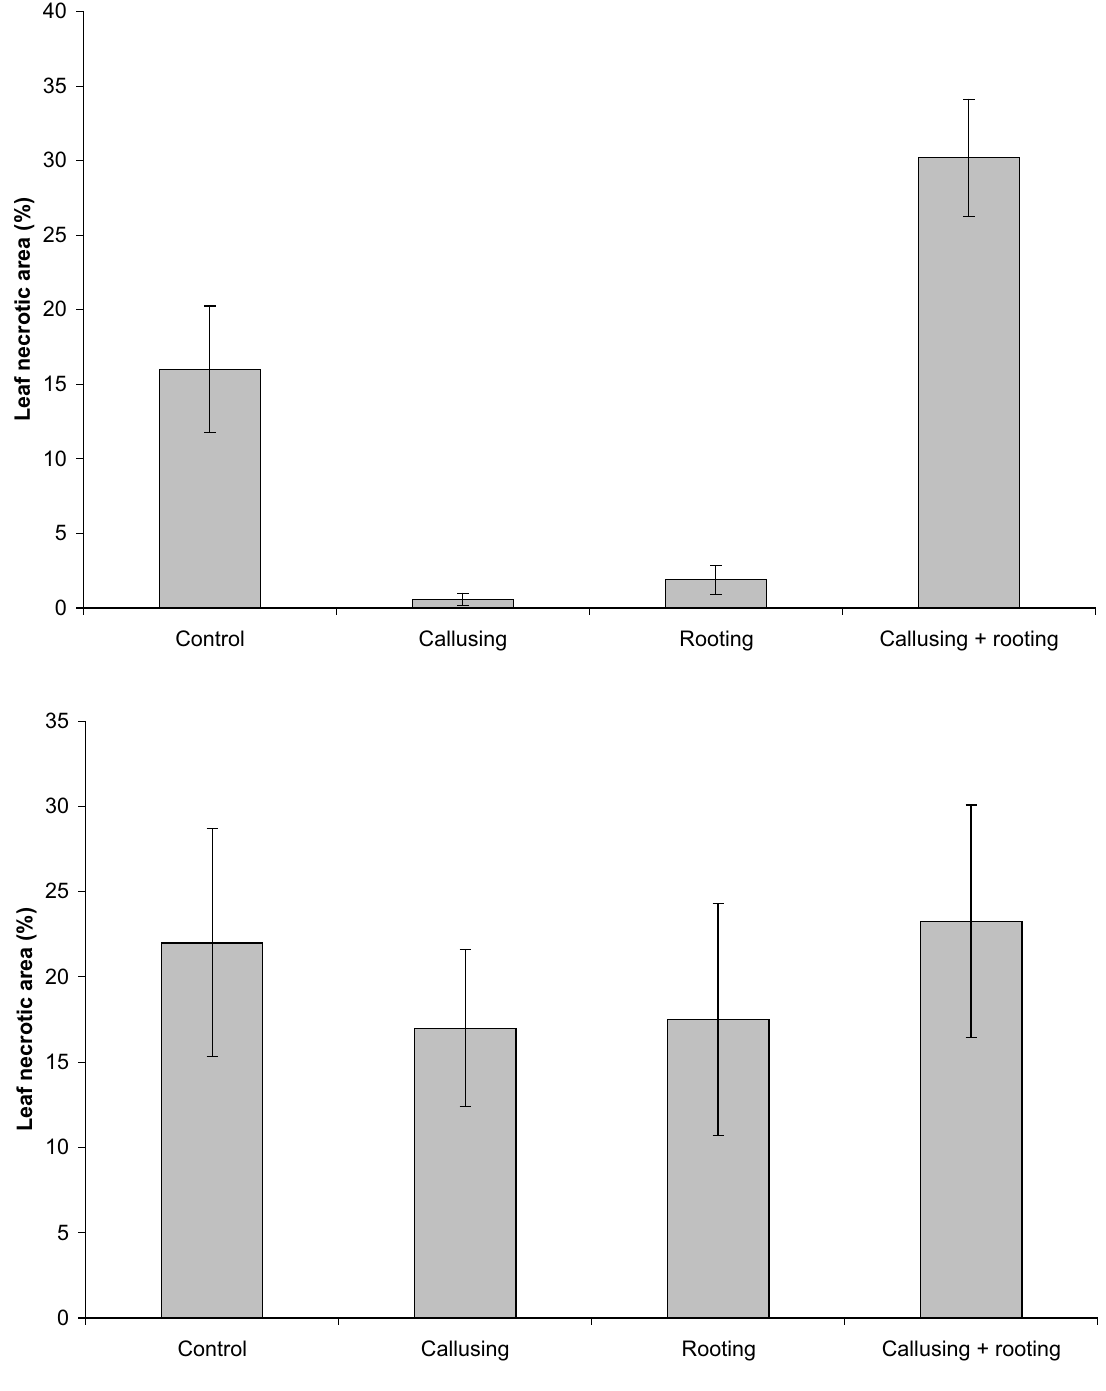
Fig. 4. Percentage of leaf area affected by necrotic lesions caused by Botrytis cinerea artificially inoculated on leaves collected from Trebbiano romagnolo cuttings on 1103P (top) and K5BB (bottom) grown in the nursery field. The assessment was carried out 7 days after inoculation. Bars represent standard